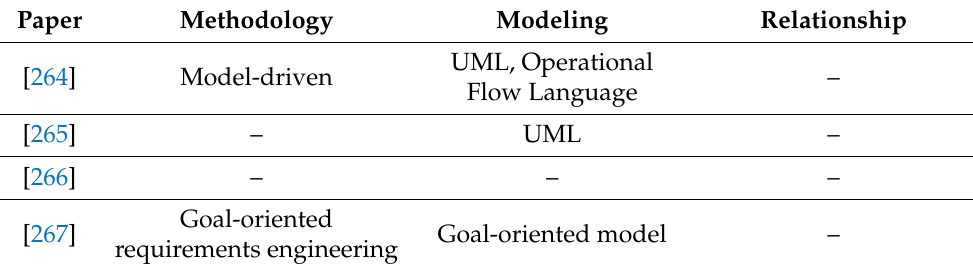
Table 8. Classification of latest papers: